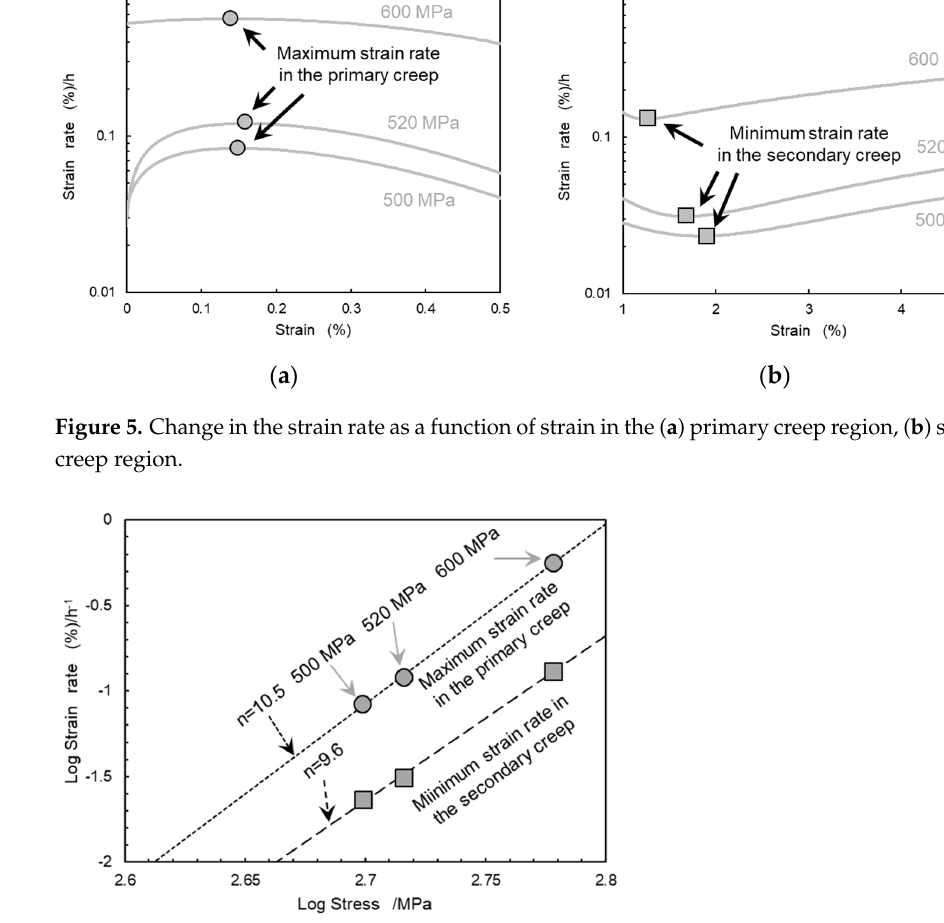
Figure 6. Summary of stress and strain rate relationship in the primary and secondary creep re- gions.